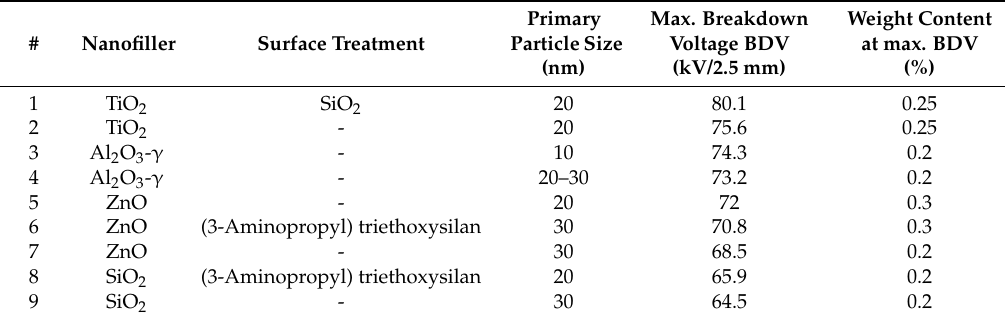
Table 7. Maximal breakdown voltages of the